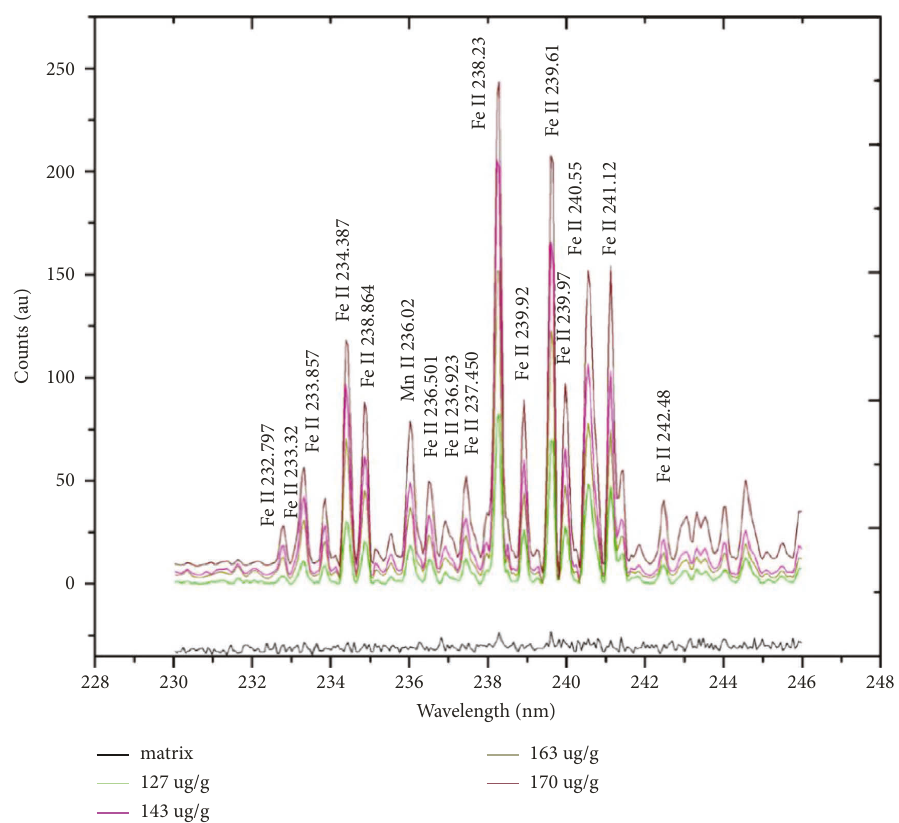
Figure 1: Laser-induced breakdown spectroscopy spectral overlay of model tissue samples with the blank matrix showing the difference in concentration levels or absence of iron in the base matrix.